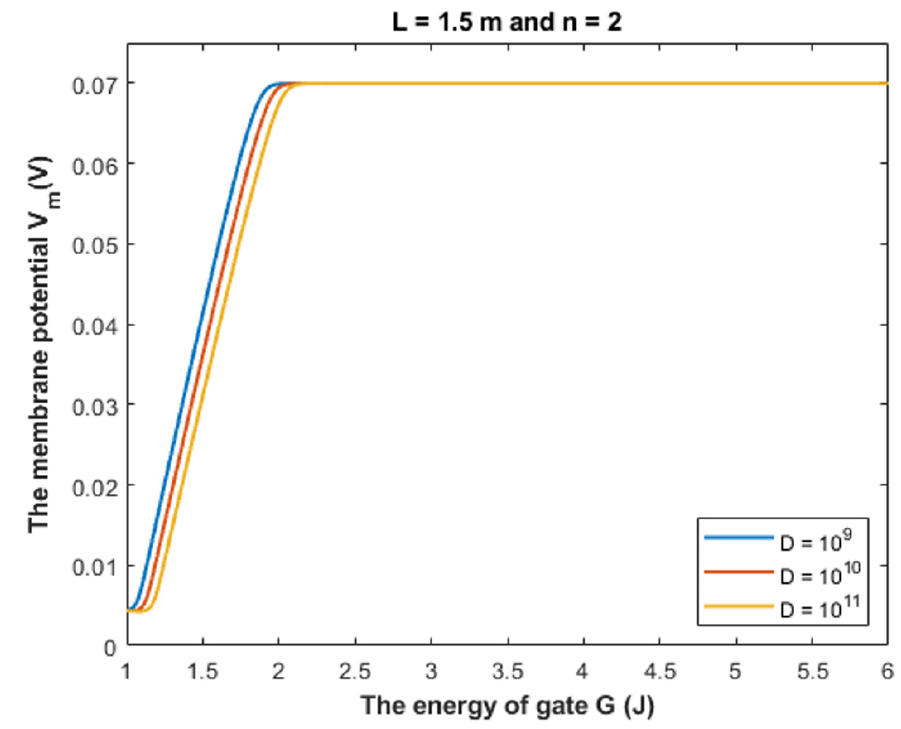
Figure 15. The figure represents the influence of the energy of gate G on the resting membrane potential according to different values of gate location and according to the setting values above the figure.